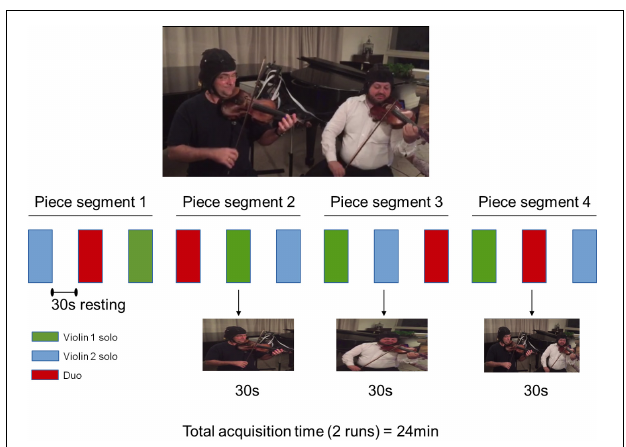
FIGURE 1 | Experimental procedure in one run. Four segments of the musical piece were split in three parts played as Violin 1 solo (green), Violin 2 solo (blue), and Violins 1 and 2 in duo (red). The order of performance of each violin part was counterbalanced across segments. Violin 1 and Violin 2 roles were reversed in the second run (not shown). Written informed consent was obtained from the violinists for publication of this image.